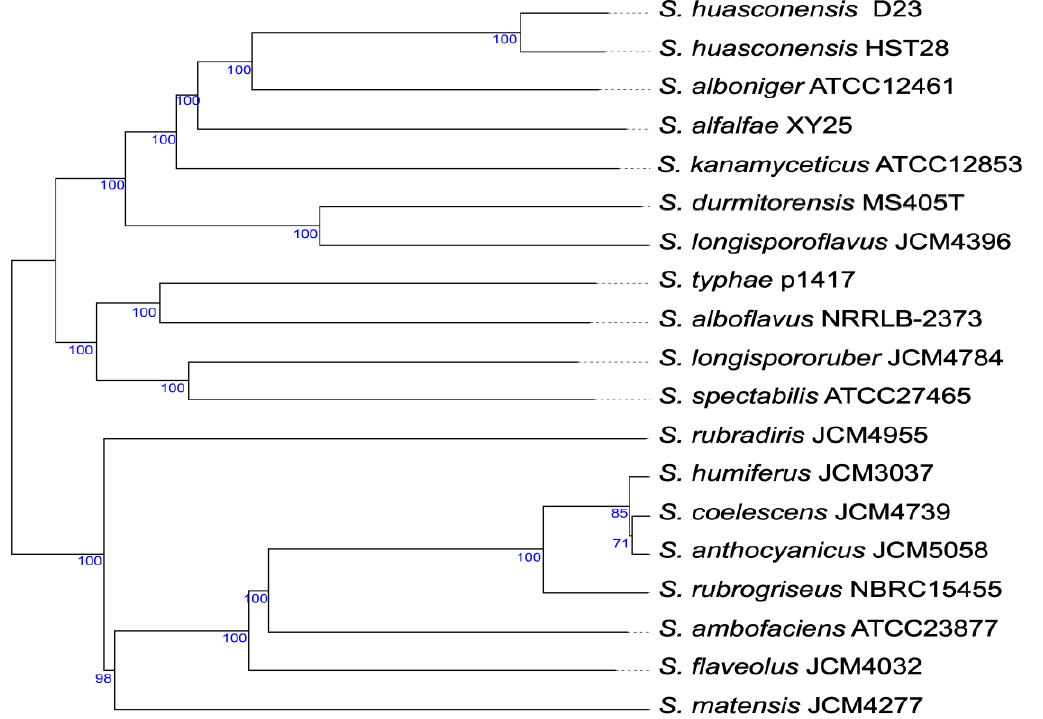
Figure 1. Phylogenomic tree based on genome sequences in the TYGS tree inferred with FastME 2.1.6.1 [30] from Genome BLAST Distance Phylogeny approach (GBDP); distances calculated from genome sequences. The branch lengths are scaled in terms of GBDP distance formula d5. The branches above are GBDP pseudo-bootstrap support values >60% from 100 replications, with an average branch support of 94.5%.